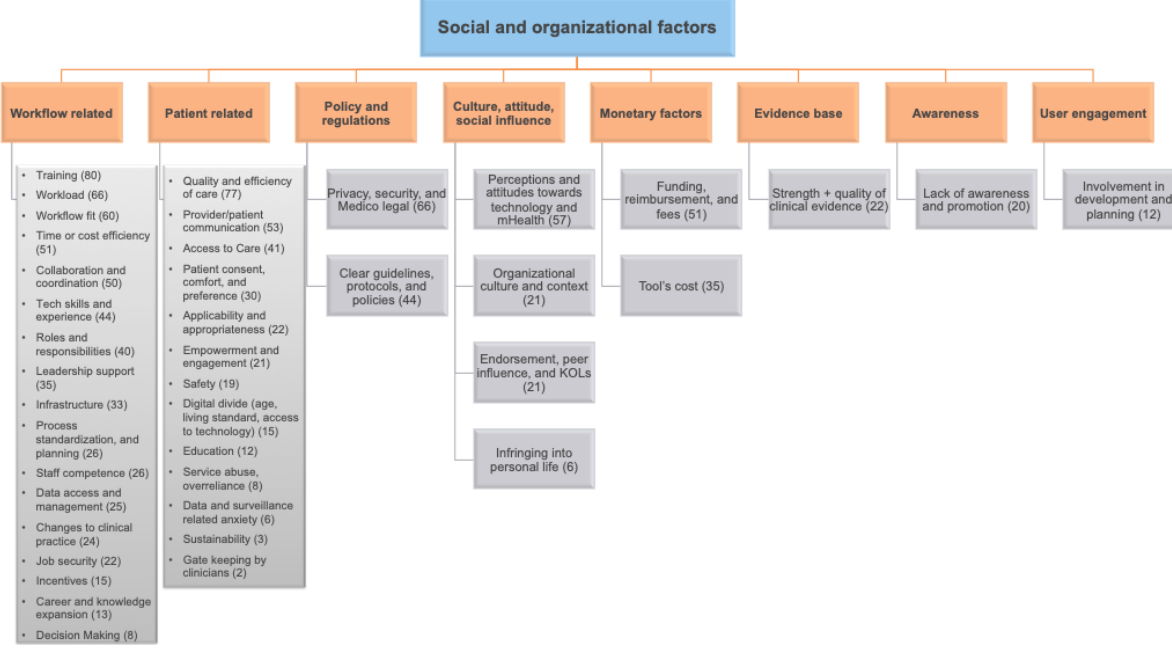
Workflow-related